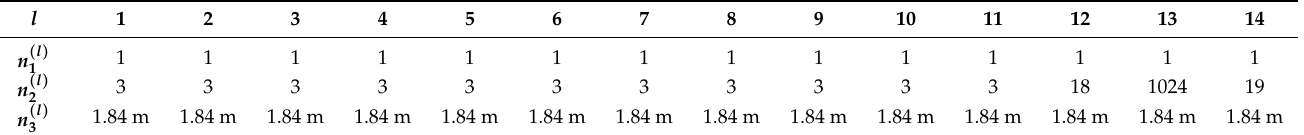
Table 1. Data dimensions for each layer.